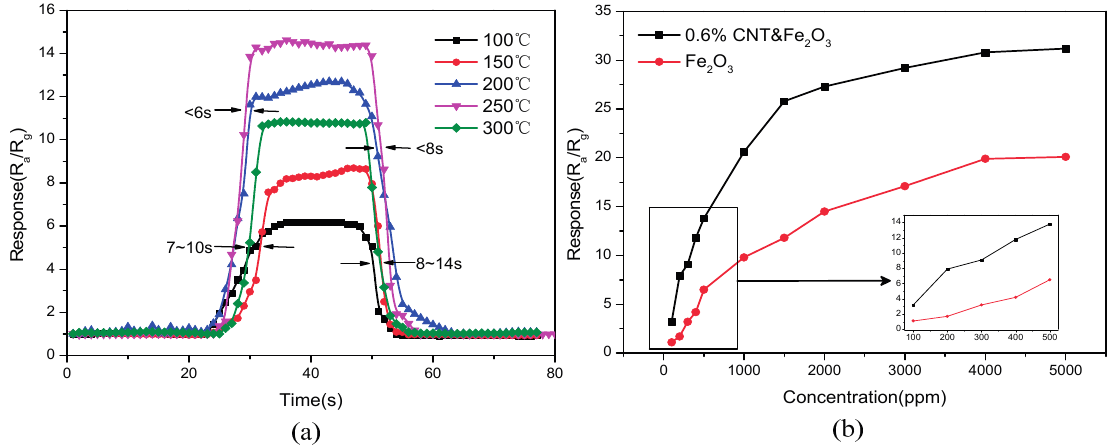
Figure 7. ( a ) Response recovery time at different sintering temperatures; ( b ) Response of sensors in different gas